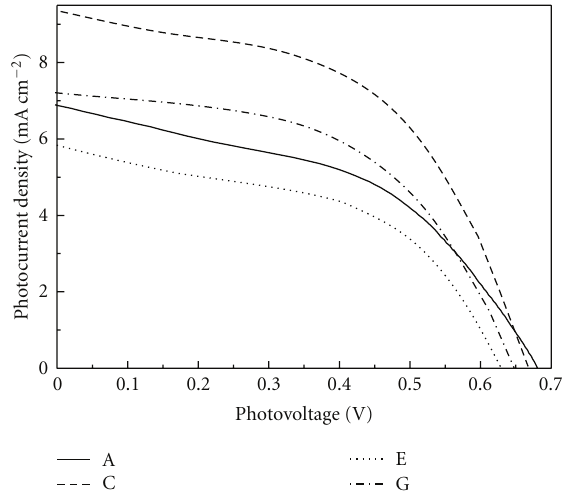
Figure 6: Photocurrent-photovoltage characteristics of DSCs with electrolytes A ∼ G. Component of electrolytes A ∼ G is the same as that in Table